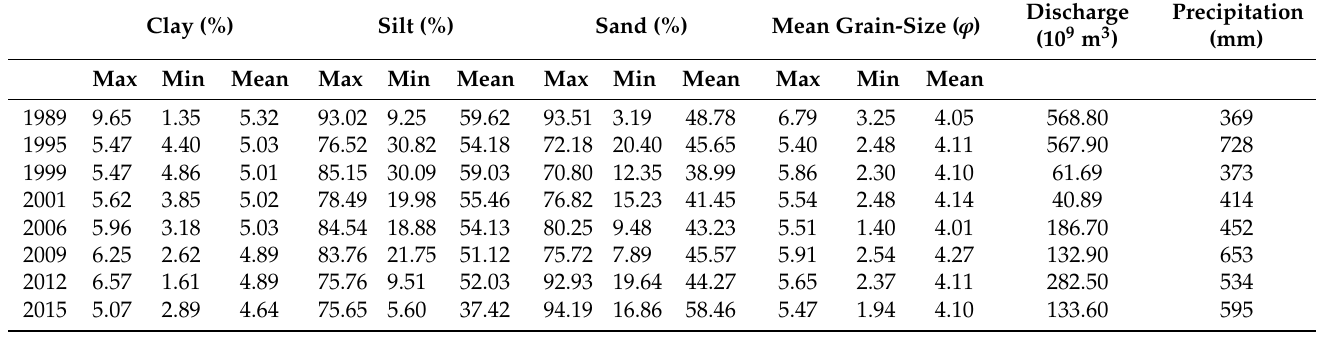
Table 3. Statistics of the SVM mapped grain-size parameters from 1989 to 2015.